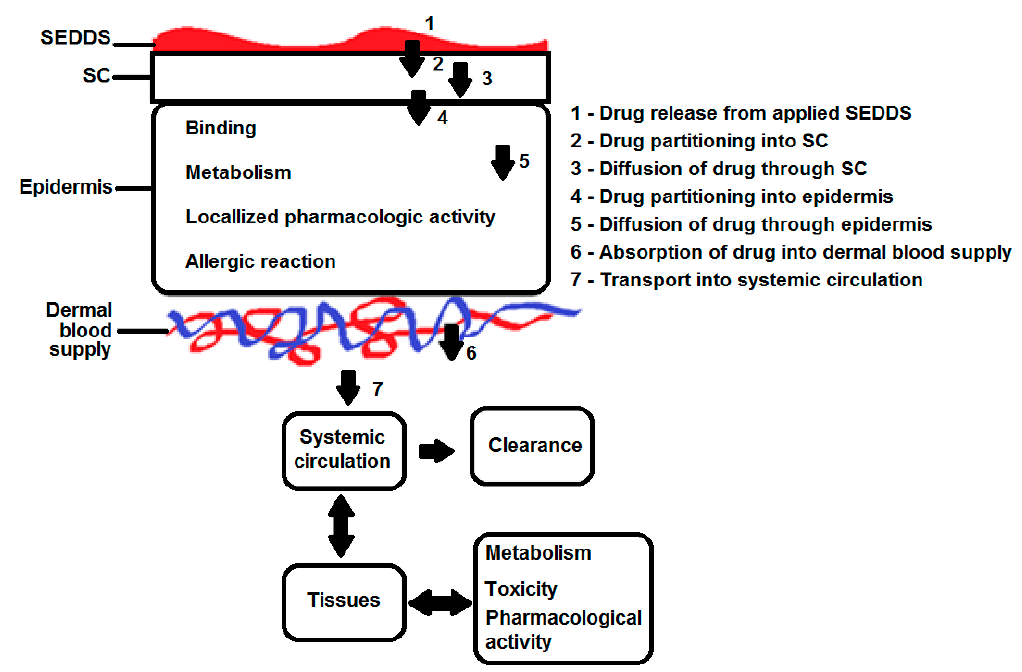
Figure 4. Dermal/transdermal uptake of SEDDSs. SC = stratum corneum.